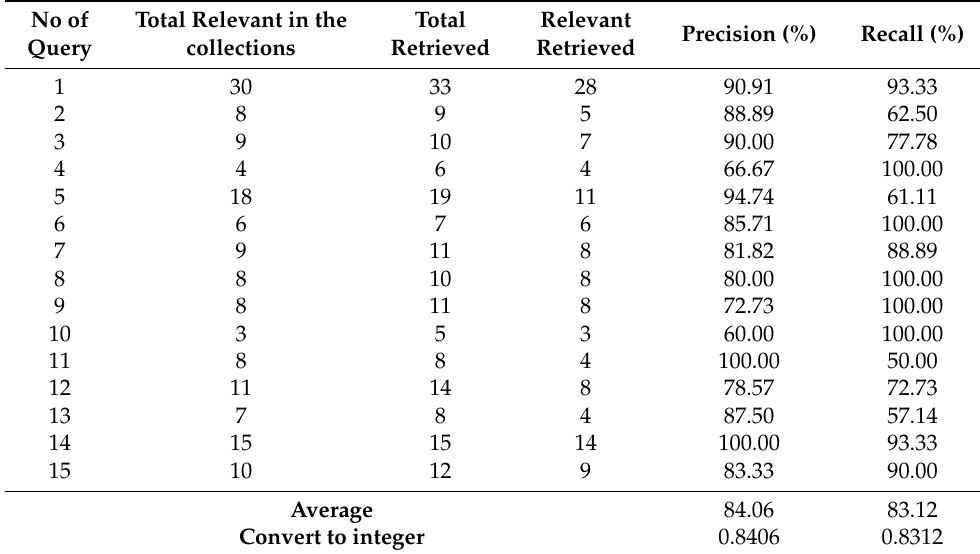
Table 3. Experimentation result—percentages of precision and